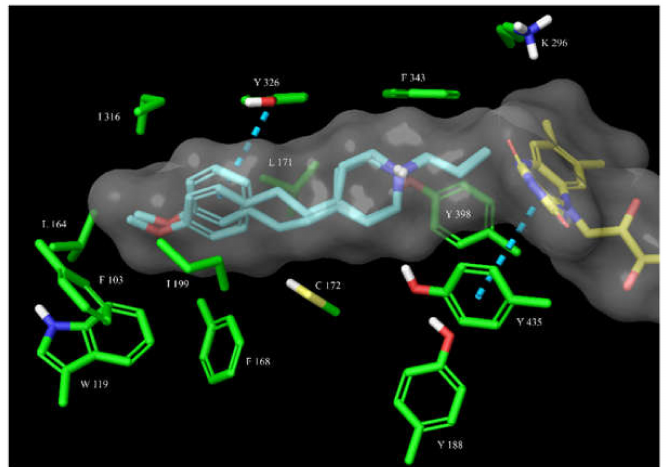
Figure 3. The overlay of docked covalently bound 7 and 8 (shown as cyan sticks) in the hMAO-B active site. The active site is shown as surface with the relevant amino acid residues shown as green sticks and the flavine adenine dinucleotide (FAD) cofactor as yellow sticks. The π - π interactions are represented by blue dashed lines. The conformations of both ligands are very alike.